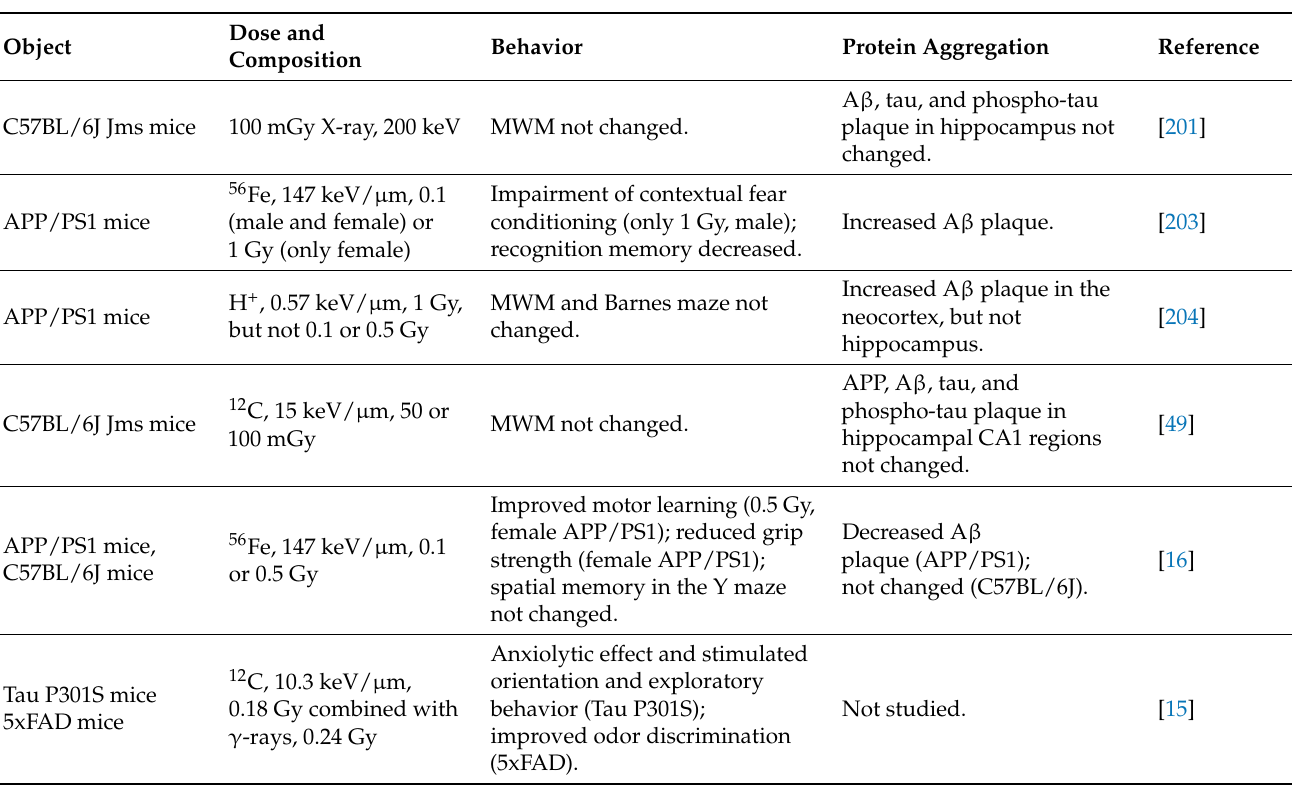
Table 2. Neurodegeneration and ionizing radiation. MWM—Morris water maze; APP—amyloid precursor protein; A β — β -amyloid peptide; tau and phospho-tau—tau protein and its phosphorylated form,